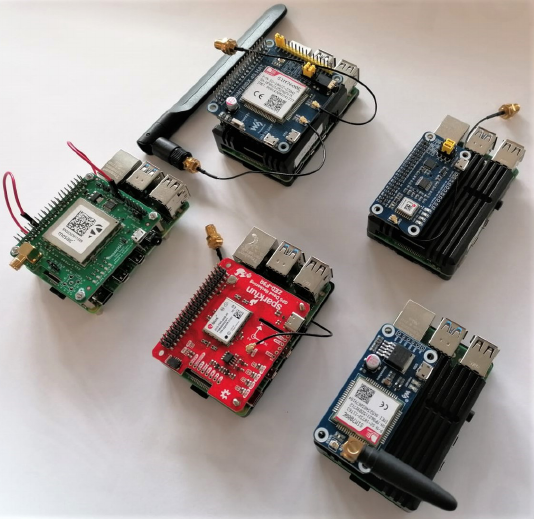
Figure 6. Alternative hardware designs. The top left is a high bandwidth LTE and GNSS pHat. Top right is a low-cost GNSS pHat with a uBlox MAX-M8Q. Bottom left Septentrio MOSAIC pHat. Bottom center uBlox F9R pHat. Bottom right NB LTE and GNSS